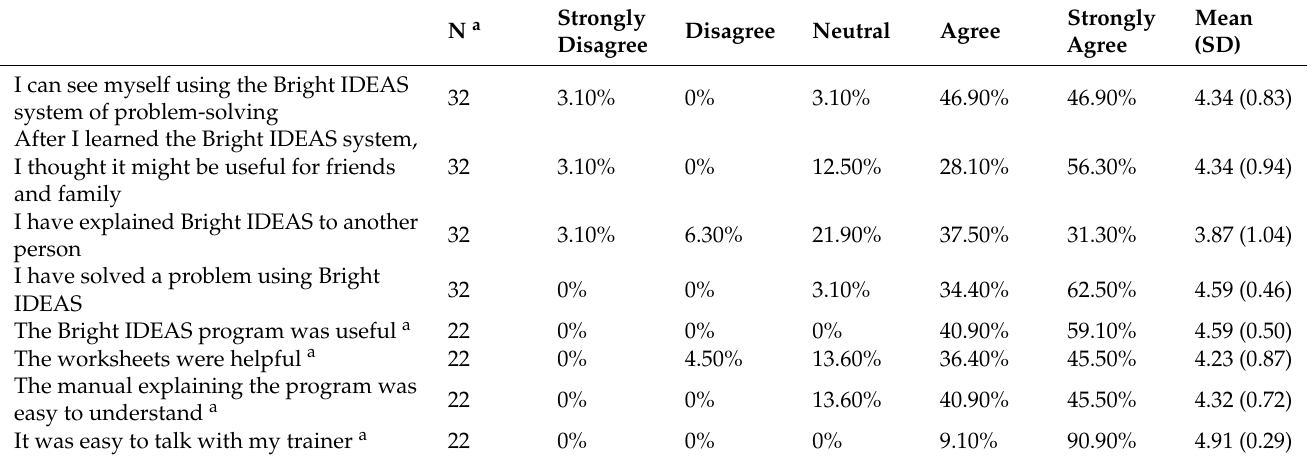
Table 2. Participant’s Satisfaction with Bright IDEAS ( n = 32).